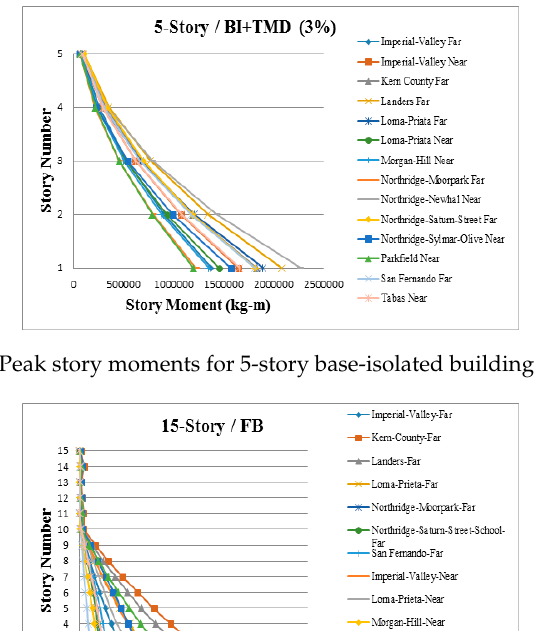
Figure A15. Peak story moments for 5-story fixed-base building with 1 TMD.